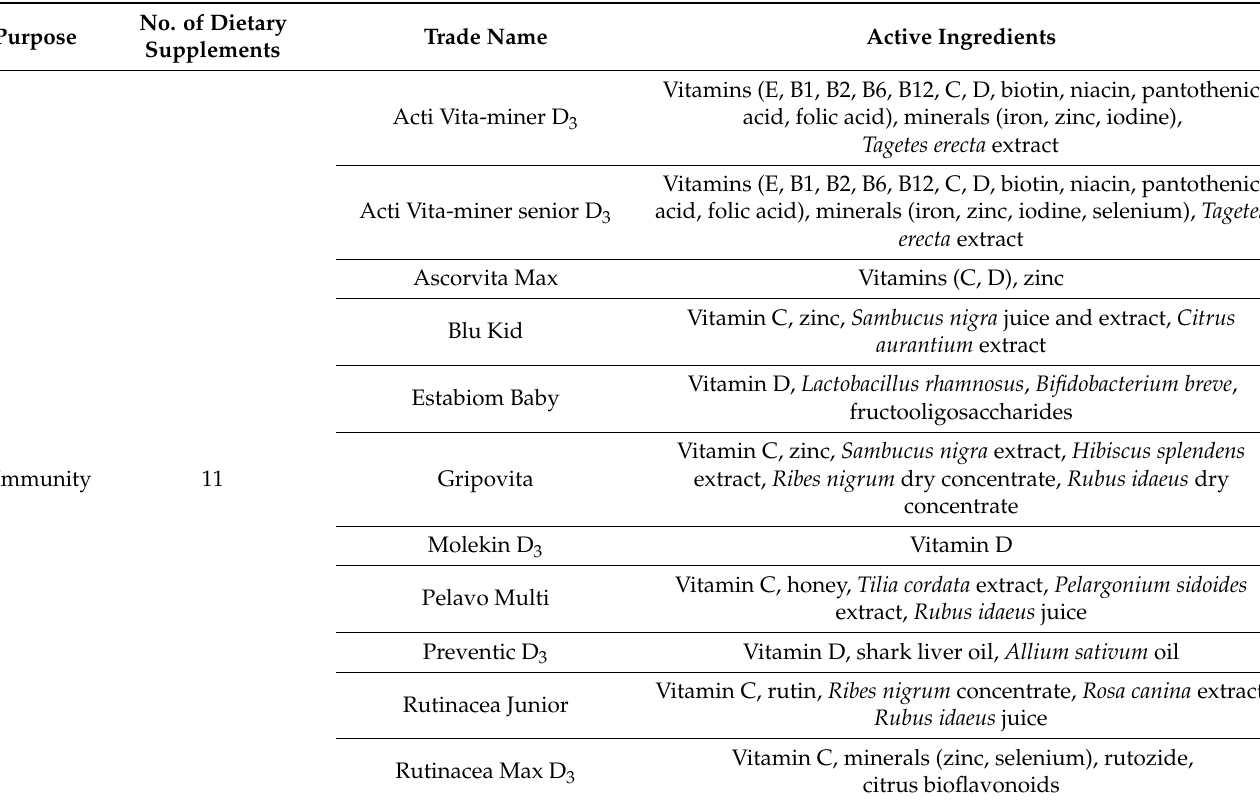
Table 1. List of the advertised dietary